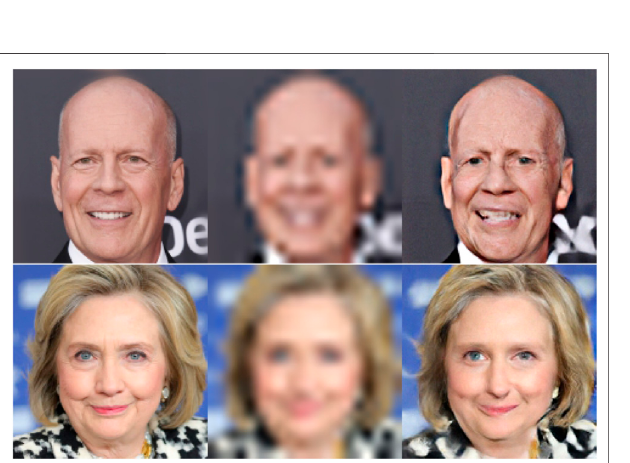
FIGURE10| ComparisonofMorganFreeman ’ sandTommyLeeJones ’ faces. The original HR image is shown on the left (downscaled to 256 × 256), the bicubic interpolated version of the LR image is shown at the center, while theGLEANsuperresolutionversionisshownontheright.Themeasured gain coef fi cient was − 0.20 and − 0.14, respectively.